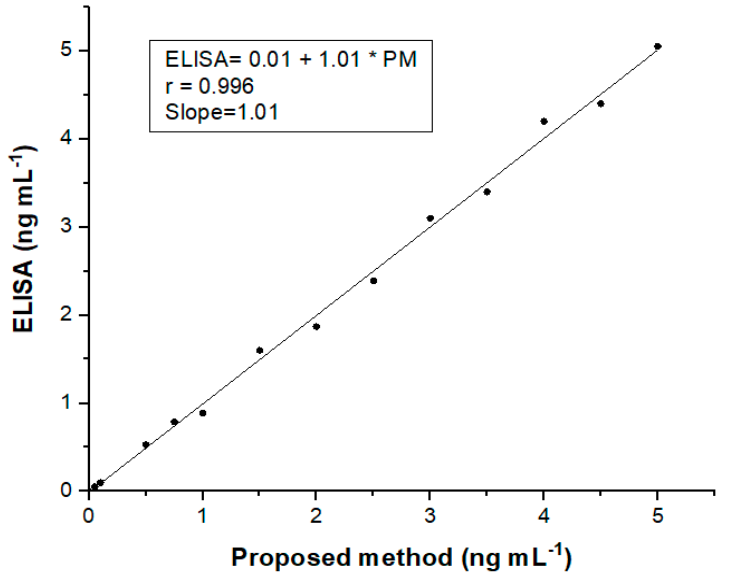
Figure 5. Correlation plot between the results obtained with the microfluidic immunosensor and the commercial ELISA kit for PSA when serial dilutions of PSA were analyzed.